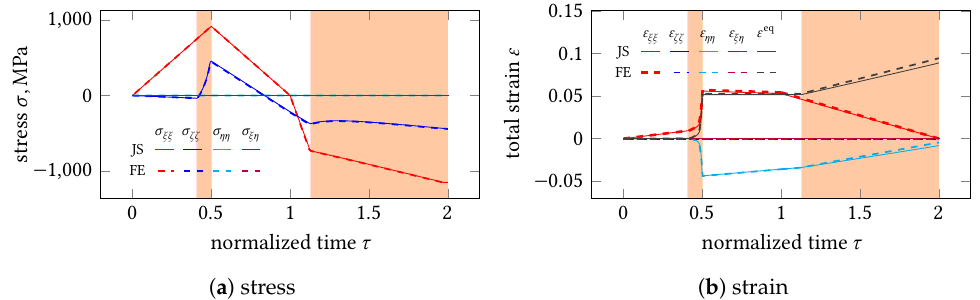
Figure 9. Stress, strain, and equivalent plastic strain evolution according to the FE analysis and the JS algorithm during both the loading cycles seen in Figure 6a and the subsequent relaxation step. Algorithms 2 and 3 were